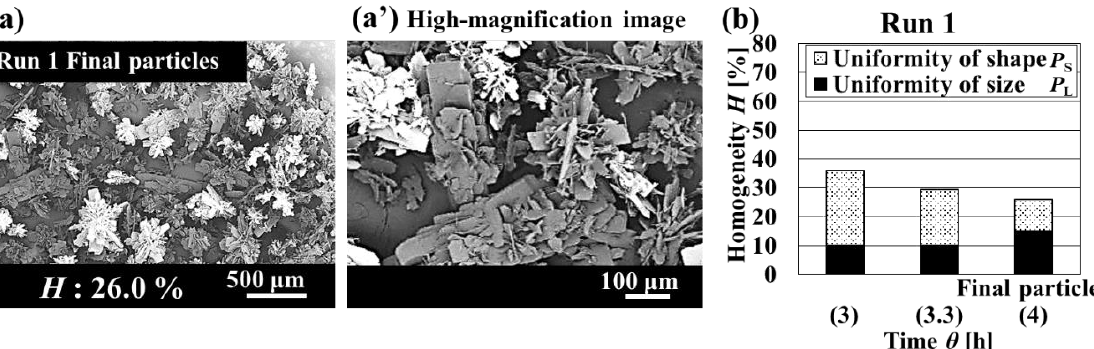
Figure 2. Quality of crystalline particles obtained in Run 1. ( a ) SEM photomicrograph of the final particles. ( a’ ) High- magnification image of the final particles. ( b ) Dynamic variation in homogeneity and uniformity of distributions of particle size and crystal shape with the crystallization time.